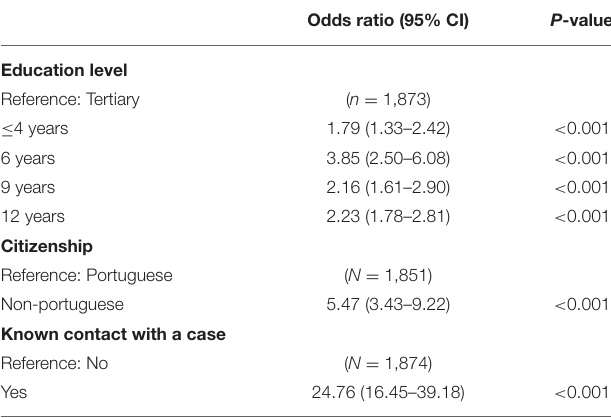
TABLE 2 | Risk of infection of SARS-CoV-2 among cases and controls from the Lisbon and Tagus Valley Region in September and October 2020 according to education level, citizenship status, and known contact with a